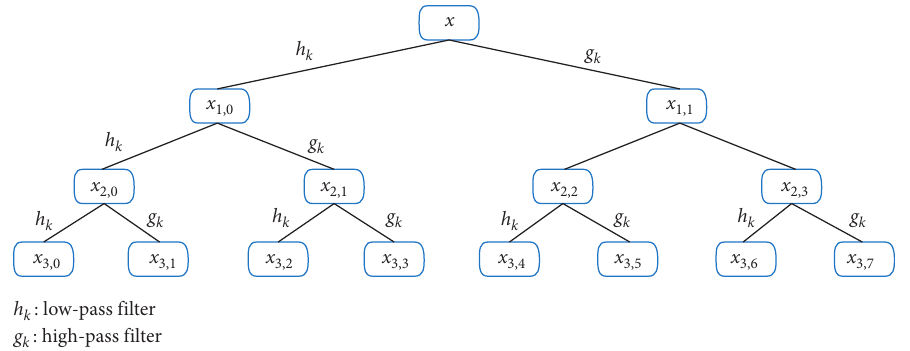
Figure 1: Schematic diagram of the three-layer wavelet packet